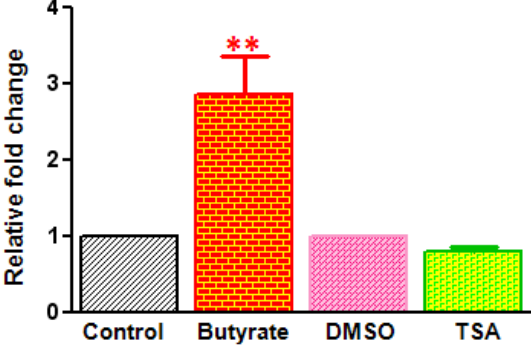
Figure 7. Cyclin D1 gene expression in butyrate and TSA treated VSMC. VSMC were treated with 5 mM butyrate or 0.5 µM TSA for 48 h and total RNA was isolated and subjected to real-time RT-PCR to quantitate cyclin D1 gene transcription. 18S ribosomal RNA was used as a normalizing control. Data are presented as mean ± S.D. from three independent experiments. ** p < 0.001 compared to control